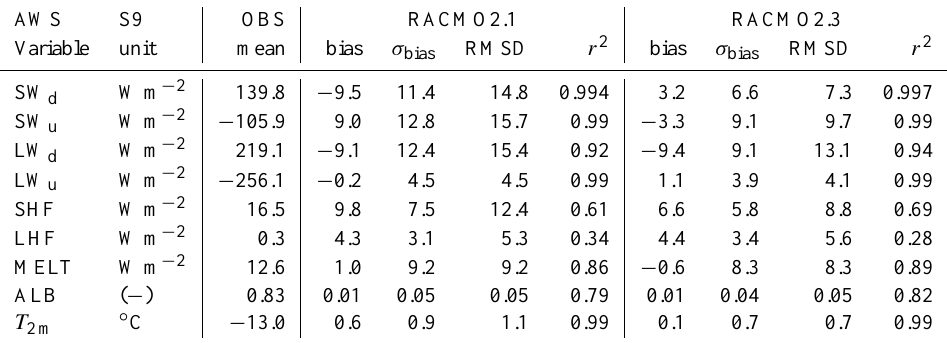
Table 2. Same as Table 1 but for station S9 (67 ◦ 03 (cid:48) N, 48 ◦ 15 (cid:48) W, 1520ma.s.l) close to the equilibrium line. SEB components include annual mean data for period 2004–2012.